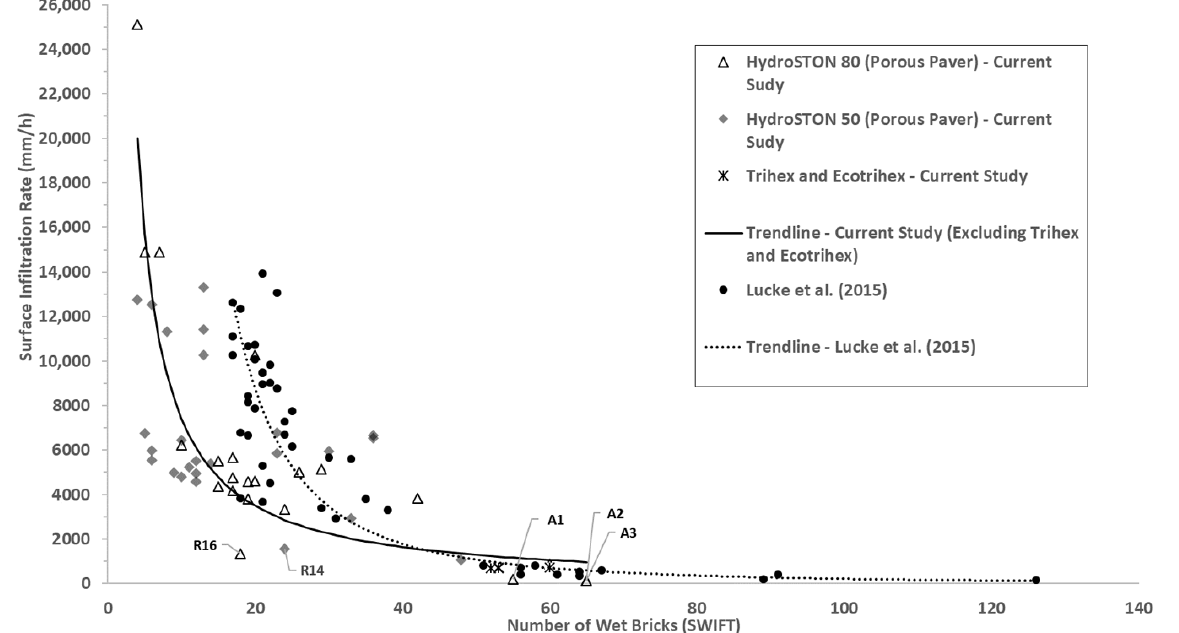
Figure 2. Comparison of PICP infiltration rates using SRIT and SWIFT tests. Data from current study and Lucke et al. [14].